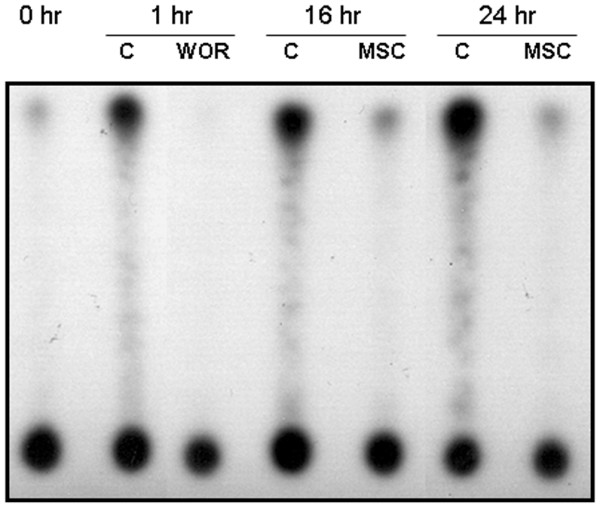
Effect of Se-methylselenocysteine (MSC) on phosphatidylinositol 3-kinase (PI3-K) activity in TM6 cells. Synchronized TM6 cells were treated with 100 μM MSC at 6 hours as described in Fig. 1. Another set of TM6 cells were pretreated with 1 μM wortmannin (WOR) for 30 min before the 1 hour stimulation with fresh DMEM/F12 medium containing growth factors (5 ng/ml epidermal growth factor and 10 μg/ml insulin) and serum (2% adult bovine serum). PI3-K activity was performed on 500 μg of protein lysates as described in the Materials and methods section. The kinase activity in the control cells increased within 1 hour of stimulation, and was strongly inhibited by WOR. The PI3-K activity in MSC-treated cells at 16 and 24 hours were drastically lowered compared with that of the control cells. The data are a representative of experiments performed in triplicate for each time point.